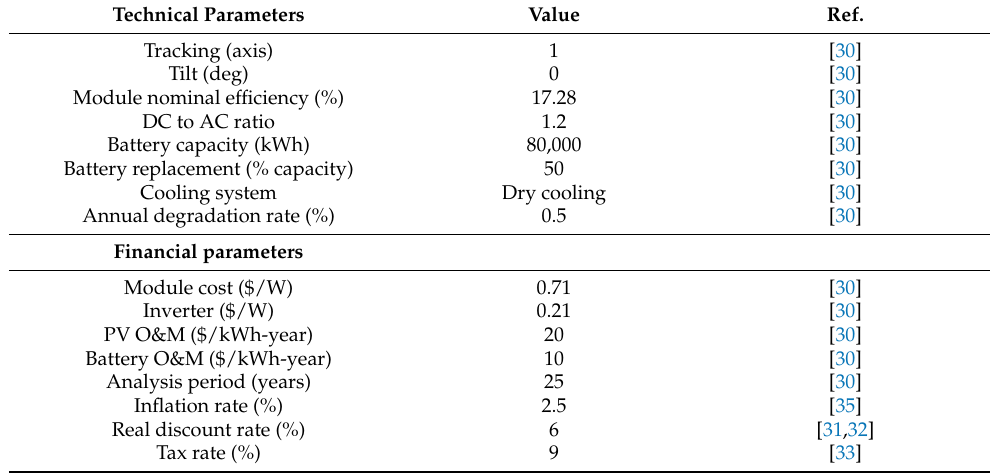
Table 2. PV’s technical and financial parameters.